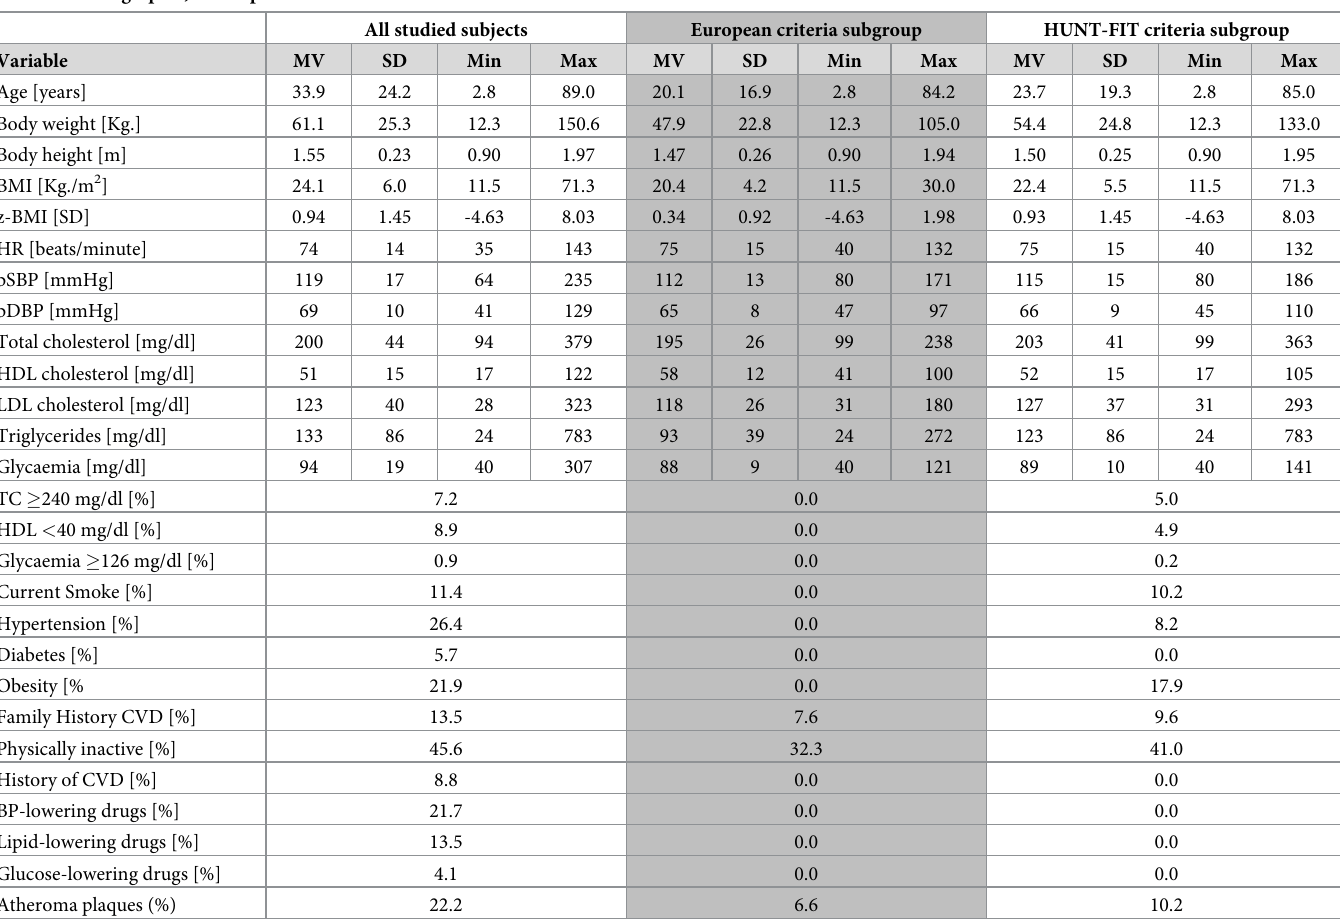
Table 2. Demographic, anthropometric and clinical